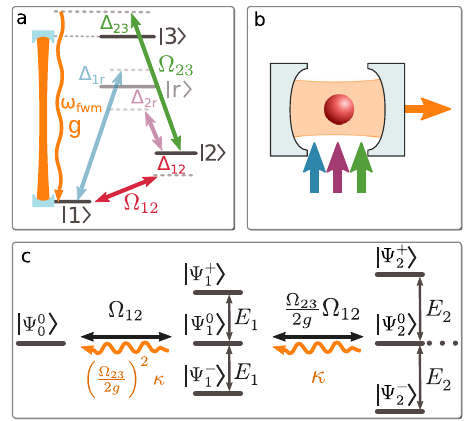
Fig. 1 System description. a The atomic level scheme with ground states 1 j i and 2 j i , the intermediate virtual state r j i and excited state 3 j i . The atom is strongly coupled to the cavity (orange) which is resonant to the transition from 1 j i to 3 j i . The system is driven by three lasers with detunings Δ 1 r , Δ 2 r , Δ fi eld with frequency ω 23 to their respective excited states. A new fwm is generated. b A sketch of the experimental setup including the atom, cavity and light fi elds that drive the atom. c The effective level scheme that forms for Ω 12 ≪ ( Ω 23 , g ), with Ω ij being the Rabi frequency of the laser drive between state i j i and state j j i with i , k ∈ 1, 2, 3. The dark state transitions are depicted with their effective driving strength and their decay rates in the (cid:1) (cid:3) (cid:1) limit of Ω 23 ≪ g . Ψ 0 ; þ ; (cid:2) represents the dark states as de fi ned in the main n text, κ the cavity- fi eld decay rate and g the coupling